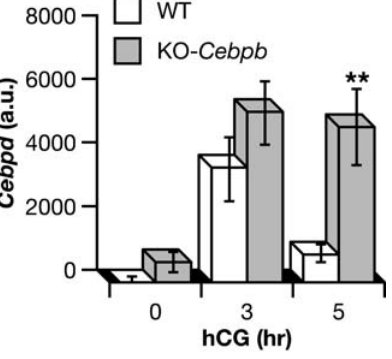
Figure 2. Down-regulation of Cebpd mRNA requires Cebpb. Phosphorimage quantitation of Northern blot analyses of whole ovary total RNA from 5 week-old Cebpb null mice (KO) or litter mate controls (WT) treated for 2 days with PMSG followed by hCG for the indicated times. Expression levels of Cebpd were normalized to cyclophilin ( Ppi ) expression and are shown in arbitrary units (a.u.; mean 6 SEM; n=3–4 mice per data point). ** P =0.01 by two-way ANOVA with follow-up comparisons among groups in the form of t -tests at each time point.